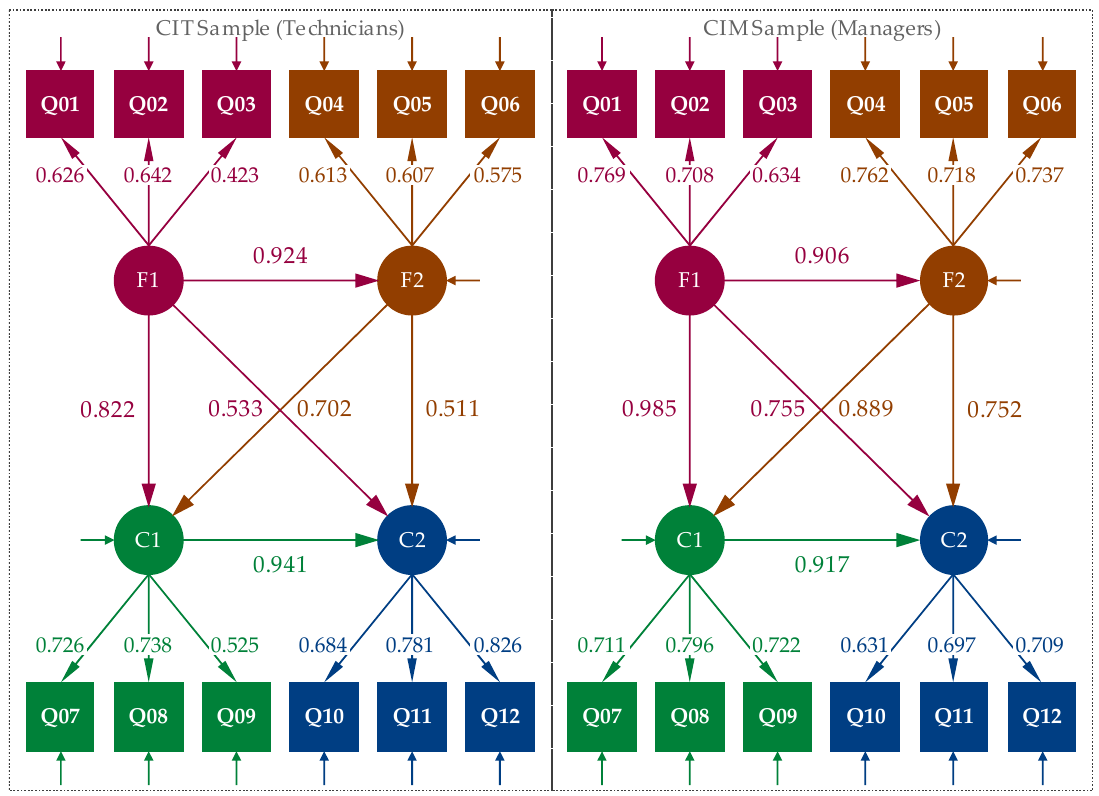
Figure 8. Final structural equation model (SEM) model (Note: Measurement errors are not shown for the sake of simplicity and to avoid information